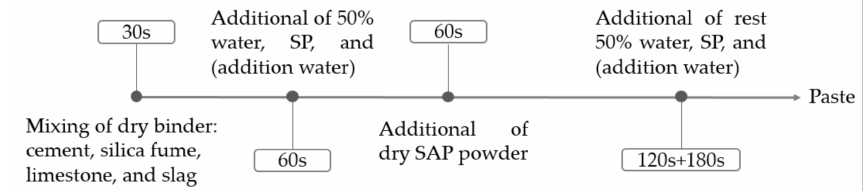
Figure 3. Mixing procedure for composite mixture